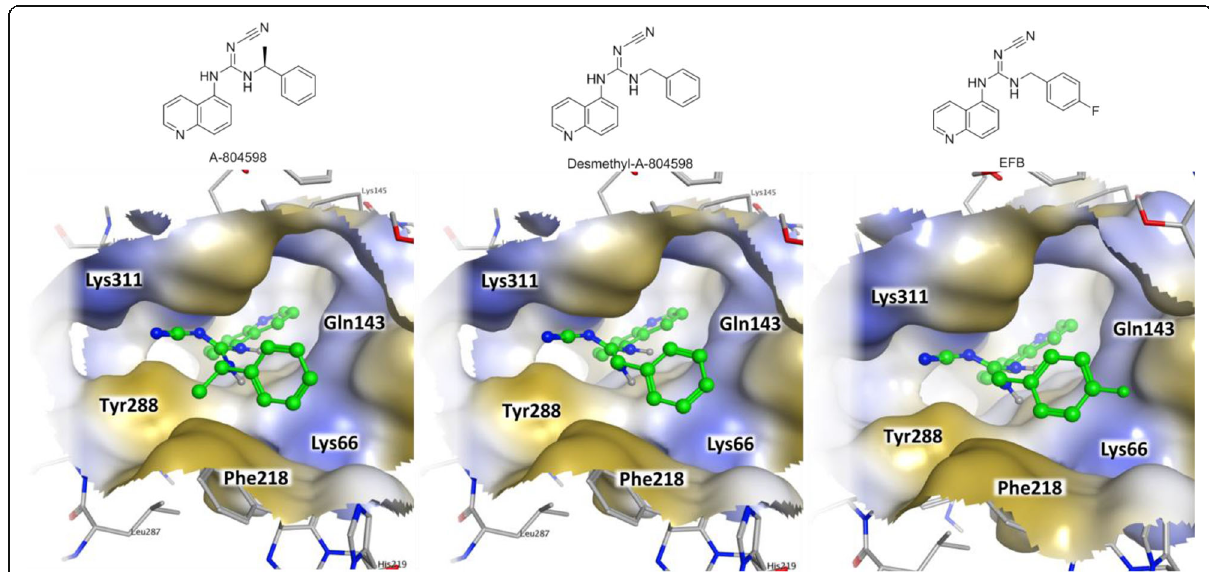
Fig. 3 Molecular docking of compounds A-804598 ( left ), its benzyl-desmethylated derivative ( middle ) and EFB ( right ) into the hP2X7 receptor ATP-binding